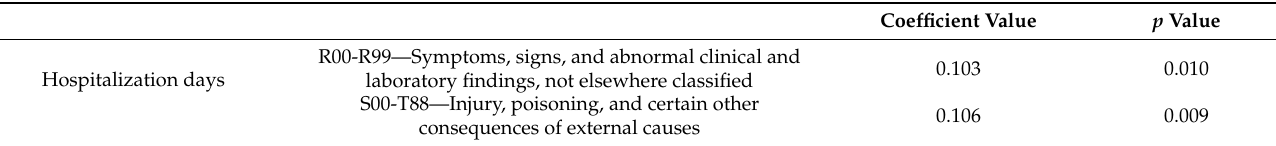
Table 3. Spearman correlation between hospitalization days and ICD-10 diagnosis.